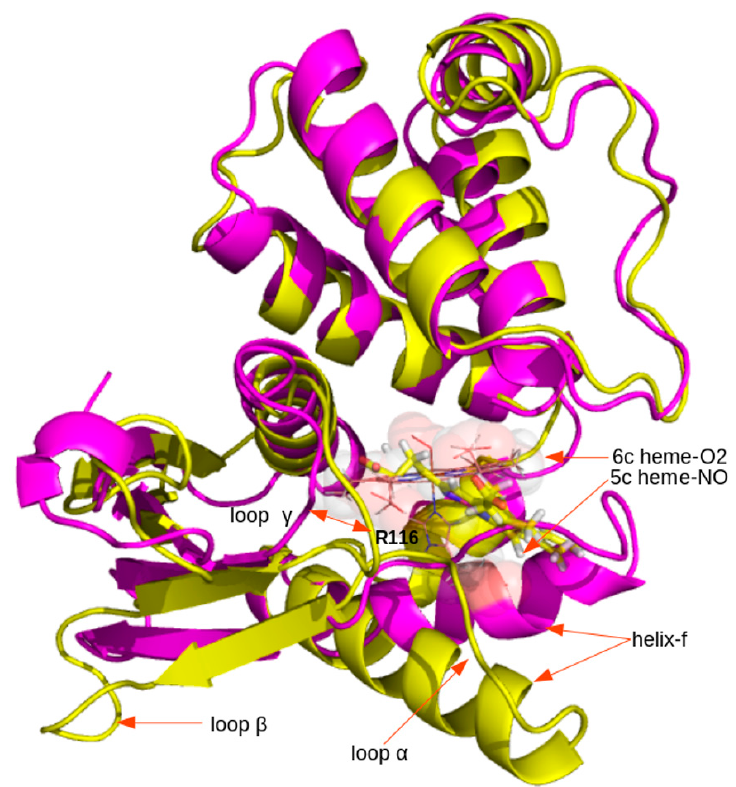
Figure 9. Superposition of HNOX-NO (yellow) and O 2 (magenta) systems. The heme-O 2 ligand is shown as transparent spheres while the heme-NO ligand is shown as sticks. Regions assumed to be important for signal transduction (helix-f, loops α , β and γ ) experienced noticeable structural changes after ligation of NO to HNOX.